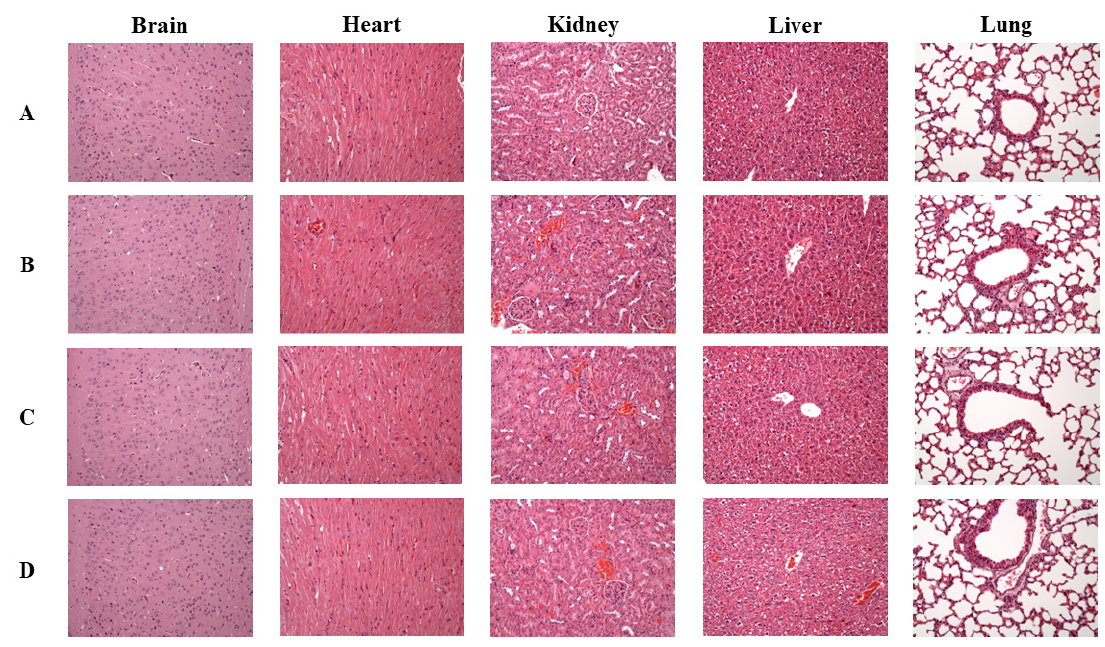
Figure 3. Effects of SPE treatment on histology of the brain, heart, liver, kidney, and lung of female SAMP8 mice (100×). Group ( A )—control group, Group ( B )—low-dose SPE (61.5 mg/kg BW/day), Group ( C )—medium-dose SPE (123 mg/kg BW/day), and Group ( D )—high-dose SPE (184.5 mg/kg BW/day).